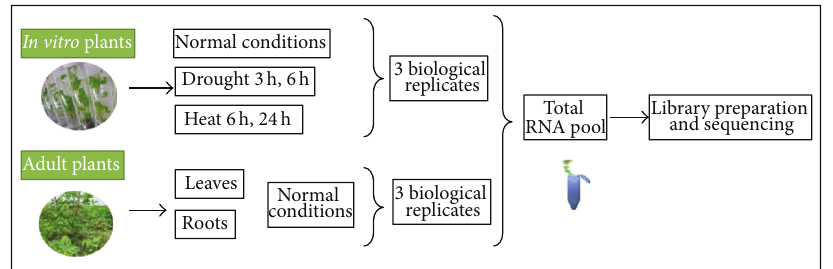
Figure 1: Source materials for RNA extraction, library preparation, and sequencing.